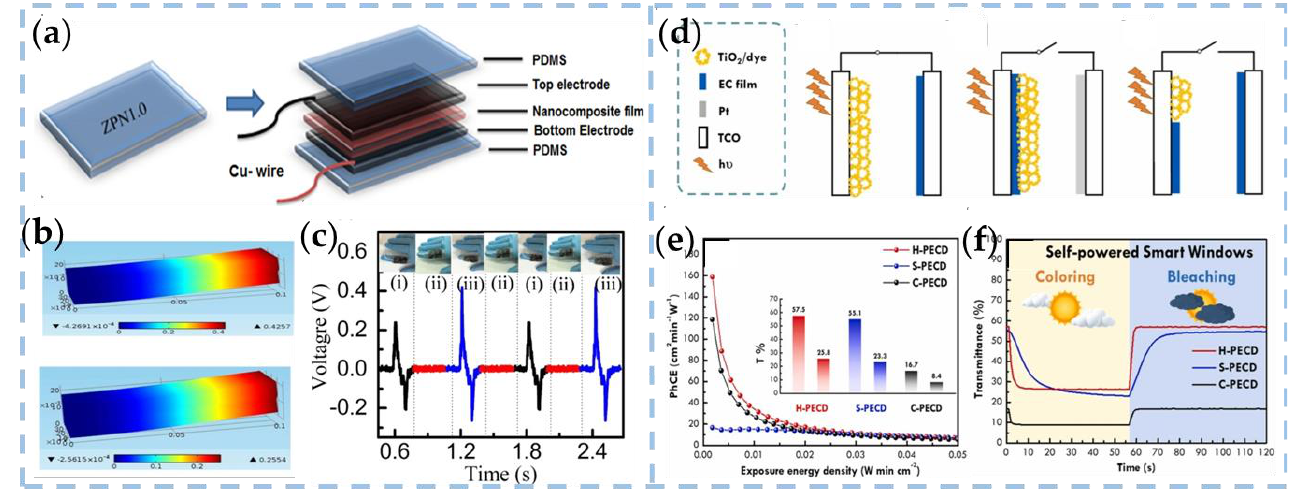
Figure 4. ( a ) Schematic diagram of the PCNG layer by layer. ( b ) Simulation of piezo potential distribution within PCNG during upward and downward bent states. ( c ) The embedded PCNG response synchronized with a human finger gesture, for example, (i) upward, (ii) relaxed state, and (iii) downward movements. [72]. Copyright 2016, IOP Publishing Ltd. ( d ) Classification of PECDs: (i) Separated type PECD (S-PECD); (ii) Combined type PECD(C-PECD); (iii) Hybrid type PECD (H-PECD) ( e ) Plot of PhCE versus exposure energy density of different types of PECDs. Inset: Transmittance for the bleached and colored states of corresponding PECDs; ( f ) Dynamic transmittance responses of different types of PECDs under illumination and dark for simulating the functional condition of corresponding self-powered smart windows under sunny and cloudy conditions [73] . Copyright 2021, ELSEVIER.